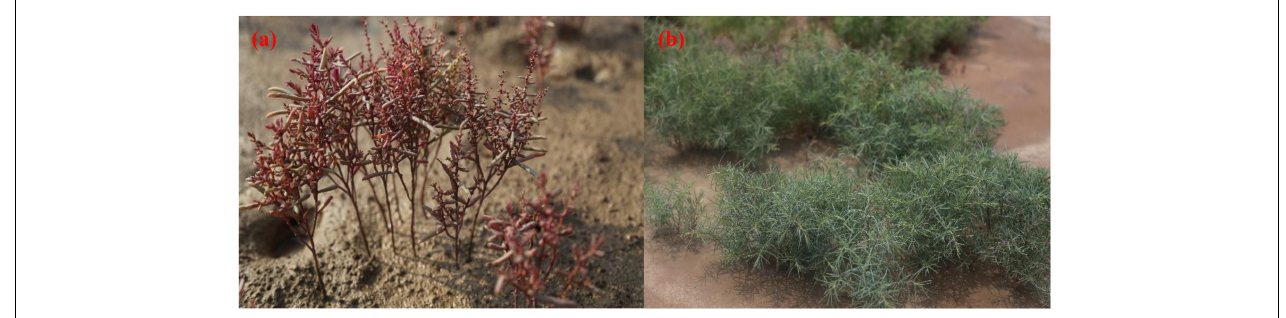
FIGURE 1 | Phenotypes of Suaeda salsa at different habitats. (a) Red-violet phenotype of S. salsa in the intertidal habitat; (b) green phenotype of S. salsa in the supratidal